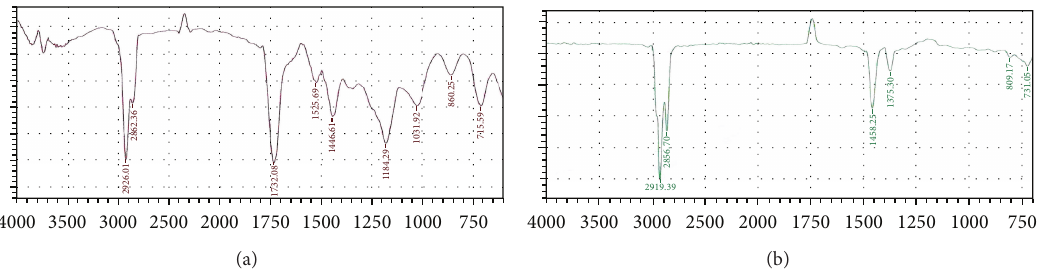
Figure 3: FTIR spectrum of (a) castor biodiesel and (b) conventional